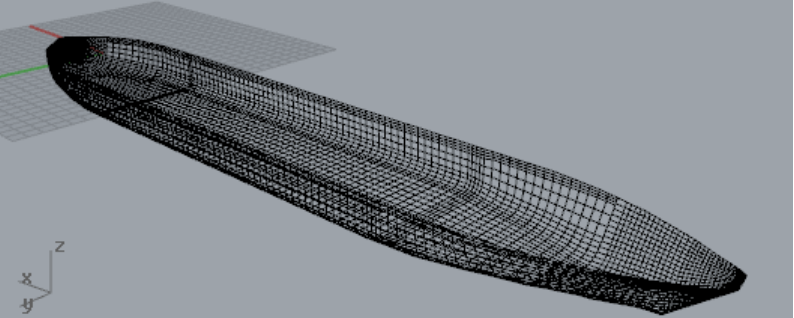
Figure 4. Floating Production Storage and Offloading (FPSO) mesh (LPP (length between perpendiculars): 310 m, B: 47 m, Draft: 15 m).